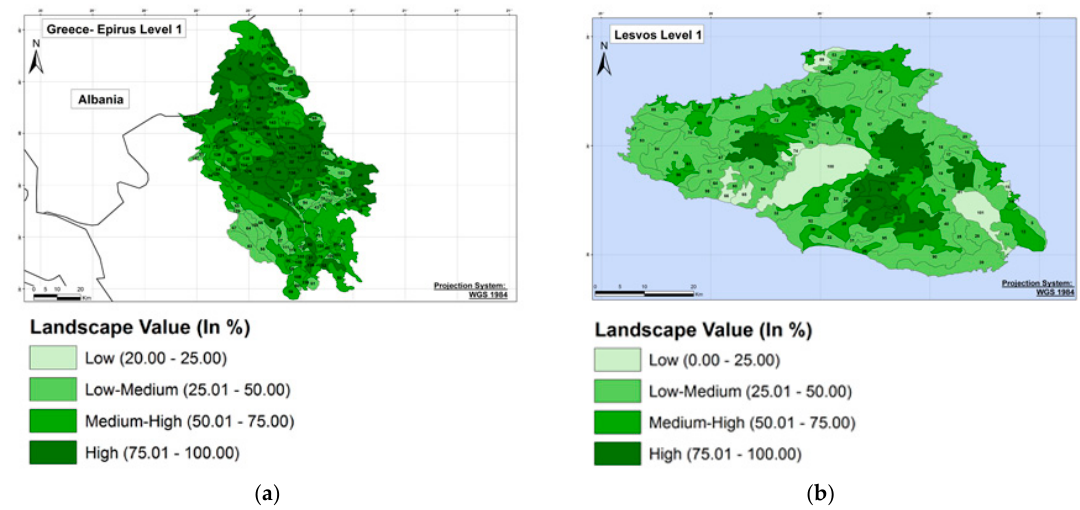
Figure 14. Landscape Value (LV) maps in Greece: ( a ) Epirus and ( b ) Lesvos. Land 2017 , 6 , x FOR PEER REVIEW